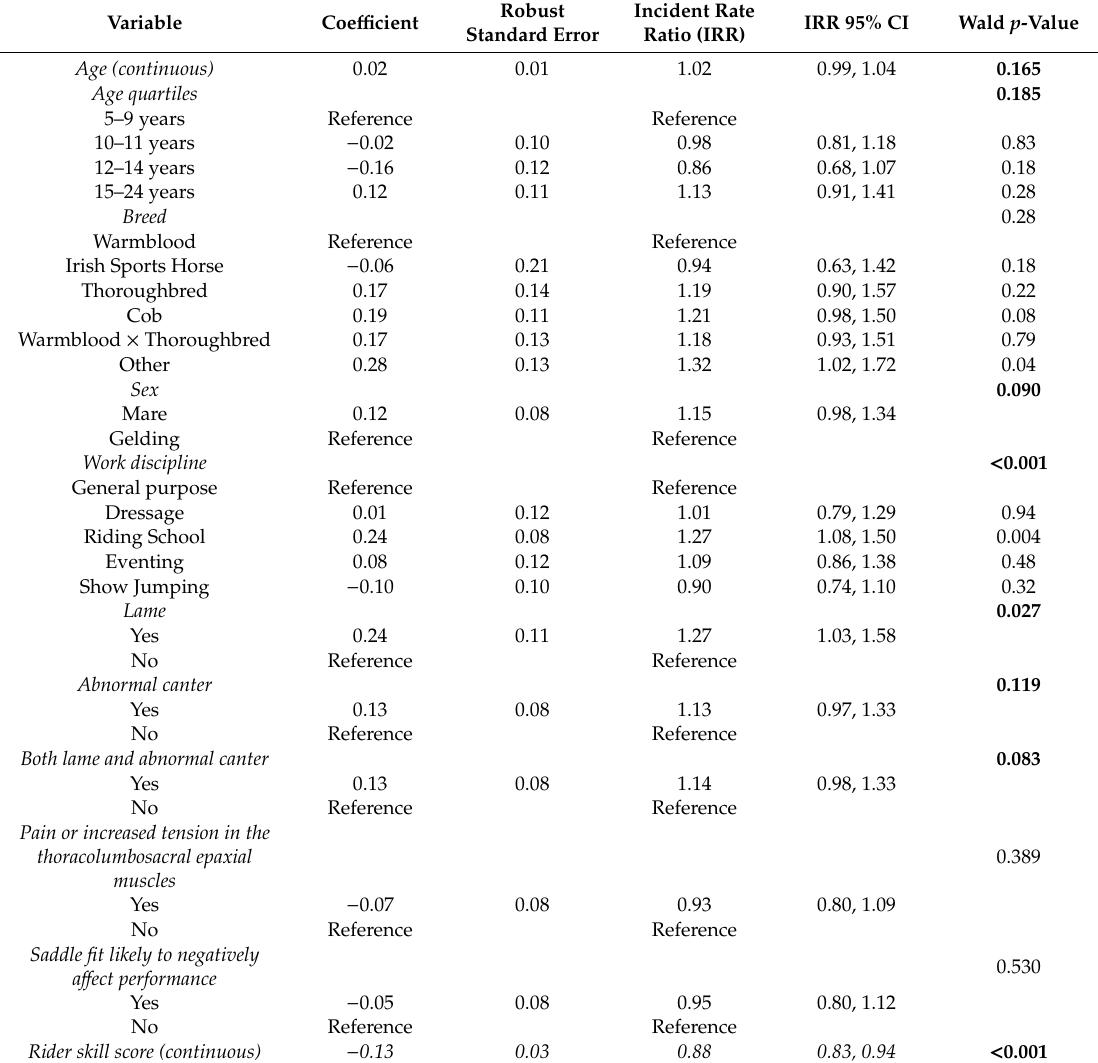
Table3. UnivariablePoissonregression, includingrobuststandarderrors, ofsignalment, workdiscipline and lameness-related variables associated with Ridden Horse Pain Ethogram scores in a convenience sample of 60 horses. CI = confidence